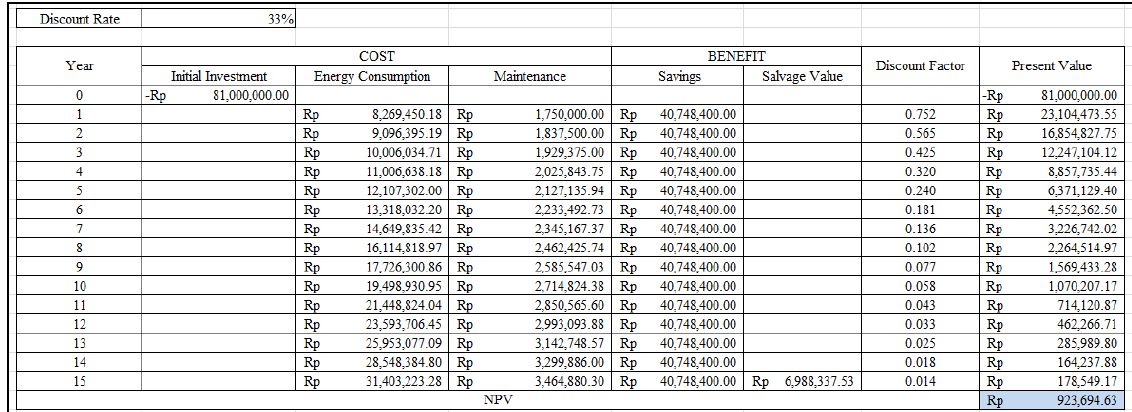
Figure 6. IRR calculation at 33%.